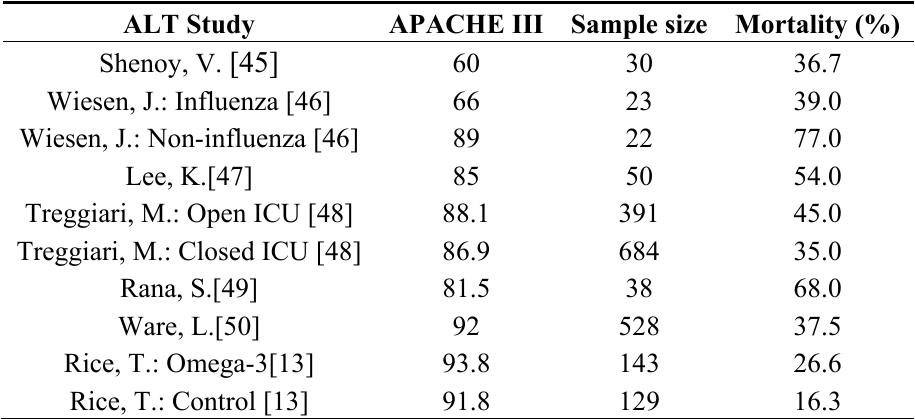
Table 4. Mortality of acute lung injury (ALI) studies using APACHE III as severity condition measures.